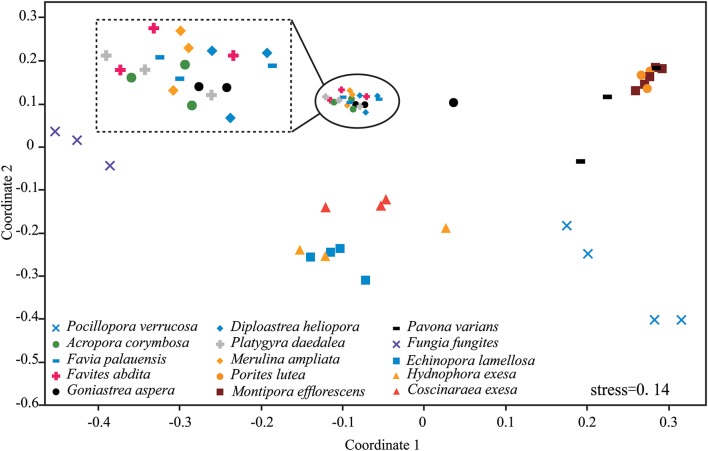
Non-metric multidimensional scaling (nMDS) plotting of the Symbiodiniaceae subclade compositions of the 15 coral species. The 2-D space allows the best spatial representation of sample similarity based on Bray-Curtis similarity indices.